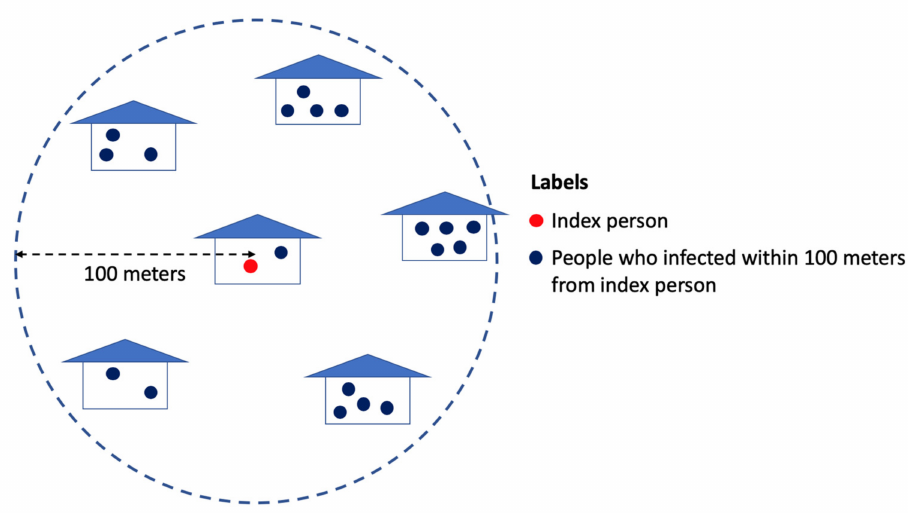
Figure 2. Spatially structured DENV